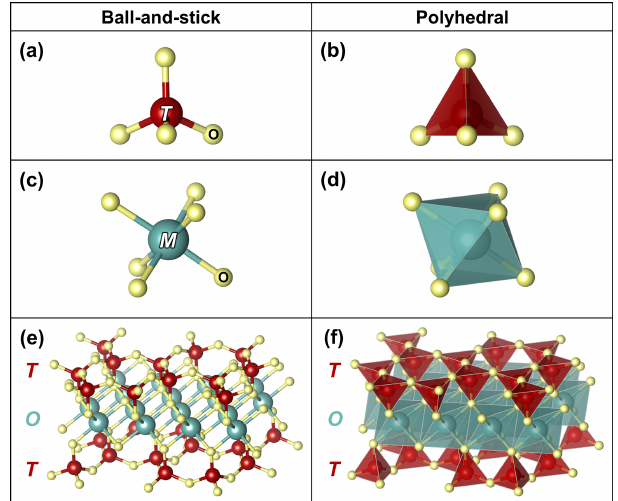
Figure 1. The two key cation sites in modular rock-forming miner- als: (a) ball-and-stick and (b) polyhedral representations of tetrahe- drally coordinated T sites, which are occupied primarily by Si, less by Al, and sometimes by Fe 3 + , with the latter best illustrated in phyllosilicates (Rieder et al., 1998); (c) ball-and-stick and (d) poly- hedral representations of octahedrally coordinated M sites, which are commonly occupied by Fe, Mg, and Al. The ligands (labelled O) are typically occupied by O and lesser OH but can also be oc- cupied by F and Cl. (e) Ball-and-stick and (f) polyhedral represen- tations of the T - O - T structure found in modular silicate minerals, consisting of chains or sheets of vertex-sharing T sites that sand- wich ribbons or sheets of edge-sharing M sites ( O ). Atomic sites are based on Hendricks and Jefferson (1939) and illustrated using VESTA (Momma and Izumi,